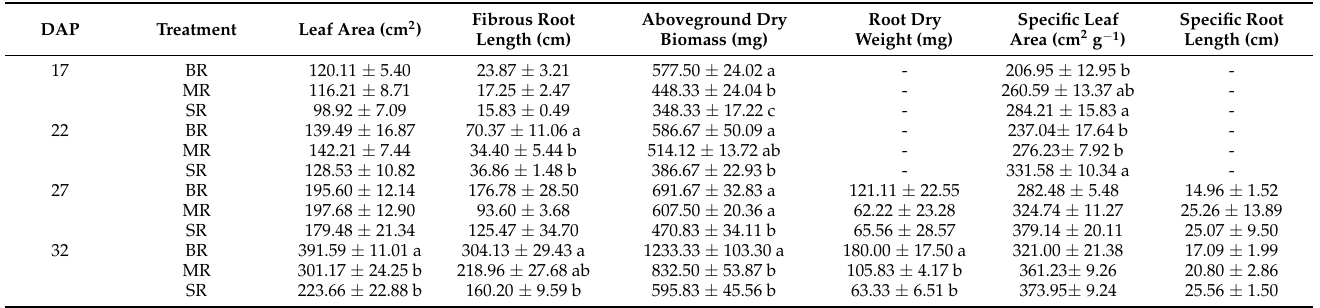
Table 2. The height, leaf area, fibrous root length, aboveground dry biomass, root dry weight, specific leaf area and specific root length of propagules on four dates in EXP.1.